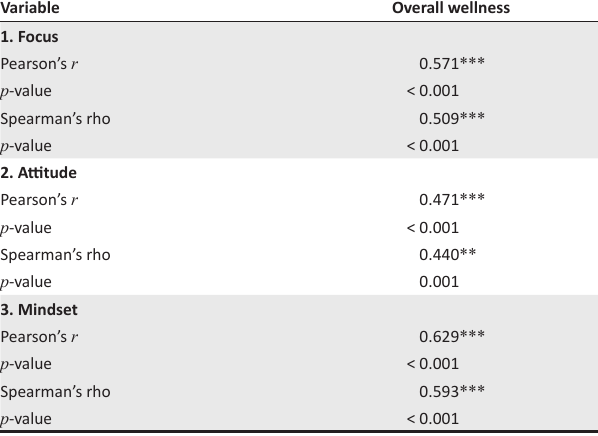
TABLE 2: Mindset, mindset subfactors and perceived wellness. Variable